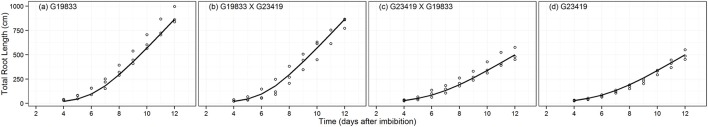
Fitted expolinear growth function for total root length (TRL, cm) of parental genotype (A) G19833, the reciprocal F1 hybrids (B) (G19833 × G23419) and (C) (G23419 × G19833), and parental genotype (D) G23419.